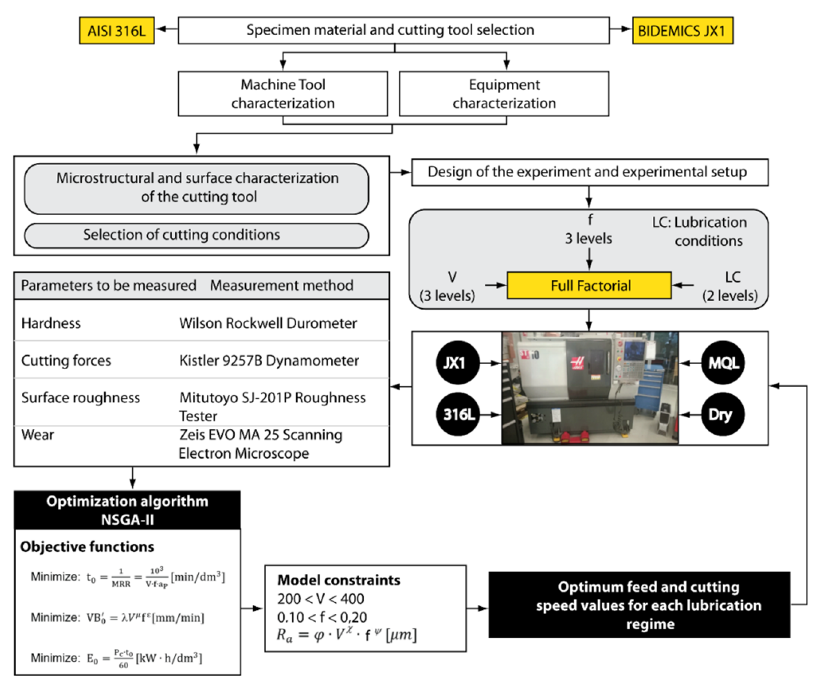
Figure 1. Procedure used in the investigation (t 0 is the unit cut-off time, V is the cutting speed, VB (cid:2868)(cid:4593) is the initial wear progression, E 0 is the unit energy of cutting, f is the feed speed, Ra is the surface roughness). NSGA-II: Non-nominated Sorting Genetic Algorithm. BIDEMICS JX1: ceramic tools.